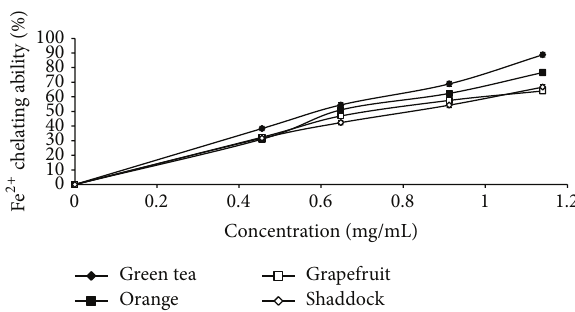
Figure 1: Monoamine oxidase inhibitory activity of infusions of green tea and some citrus peels. Values represent means ± standard deviation of triplicate readings.